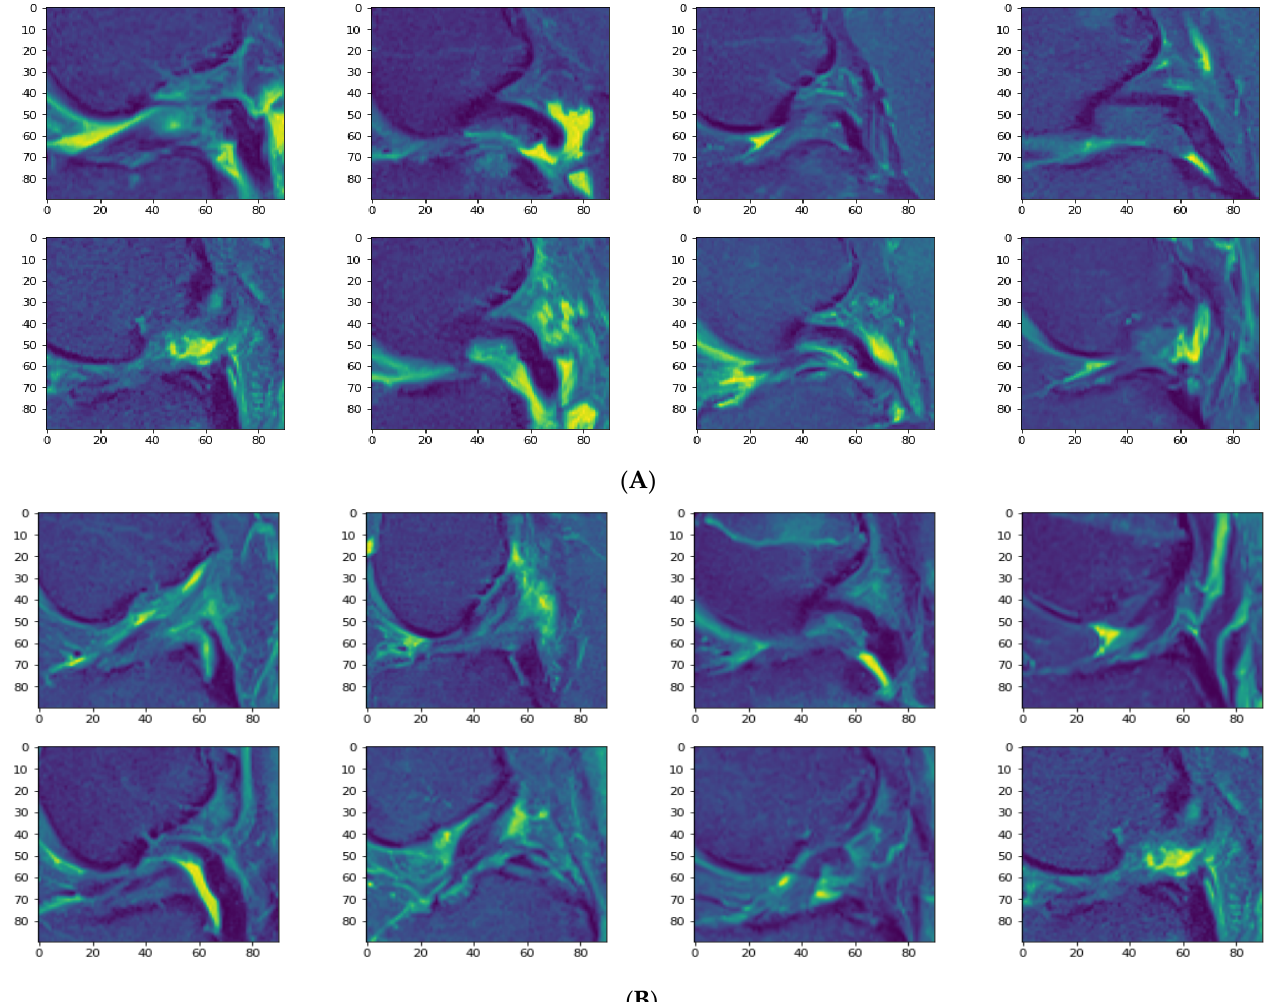
Figure 5. Samples of training and test datasets; ( A ) visualization of eight training sample images; ( B ) eight test sample images.